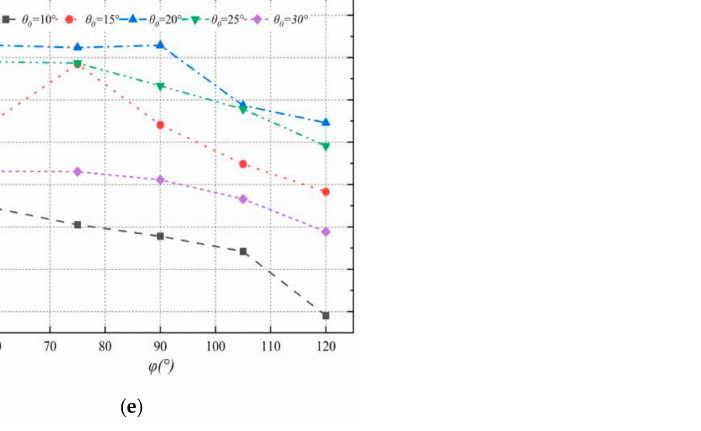
Figure 12. Variation of average thrust coefficient with phase difference under different phase differ- ences and pitch amplitude ( a ) h 0 = 0.5c ( b ) h 0 = 0.625c ( c ) h 0 = 0.75c ( d ) h 0 = 0.875c ( e ) h 0 =